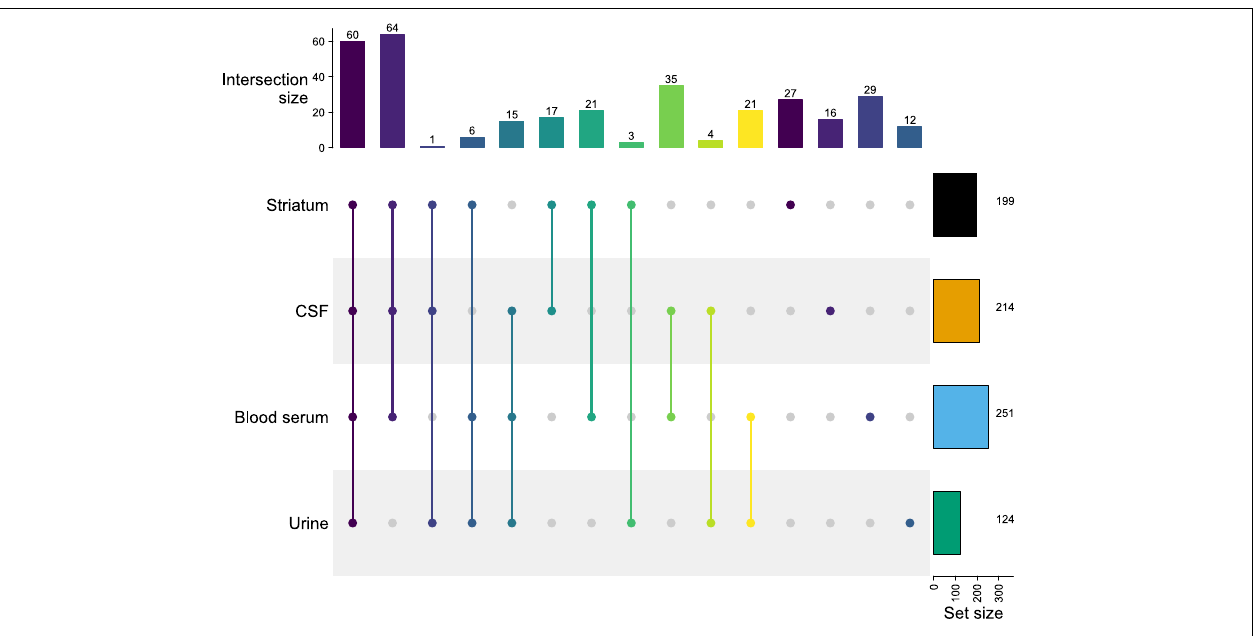
FIGURE 2 | Upset diagram based on metabolites identified within explored matrices (striatum, CSF, blood serum, and urine). Intersection size corresponds to the number of common metabolites detected in different matrices (e.g., on the second column striatum, CSF, and blood serum matrices share 64 metabolites). Set size corresponds to the total number of metabolites per